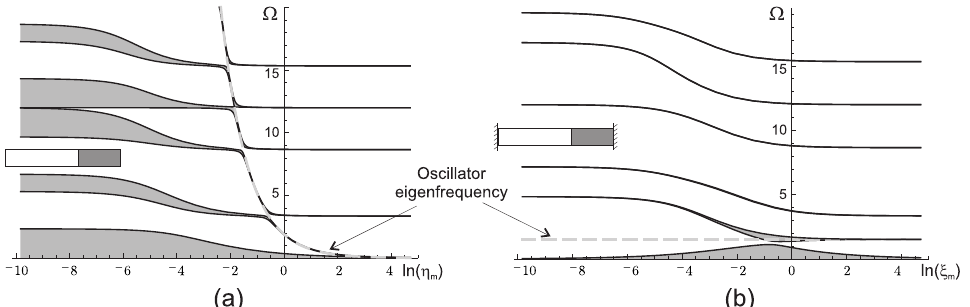
Figure 12. Oscillator in series. Distribution of the propagation band frequency Ω as a function of the ratios η m and ξ m . Results are given for ξ c = 0.22 and η c = 0.5 with ξ m = 8.71 in ( a ) and η m = 1.265 in ( b ). The grey dashed lines indicate the characteristic frequency of the